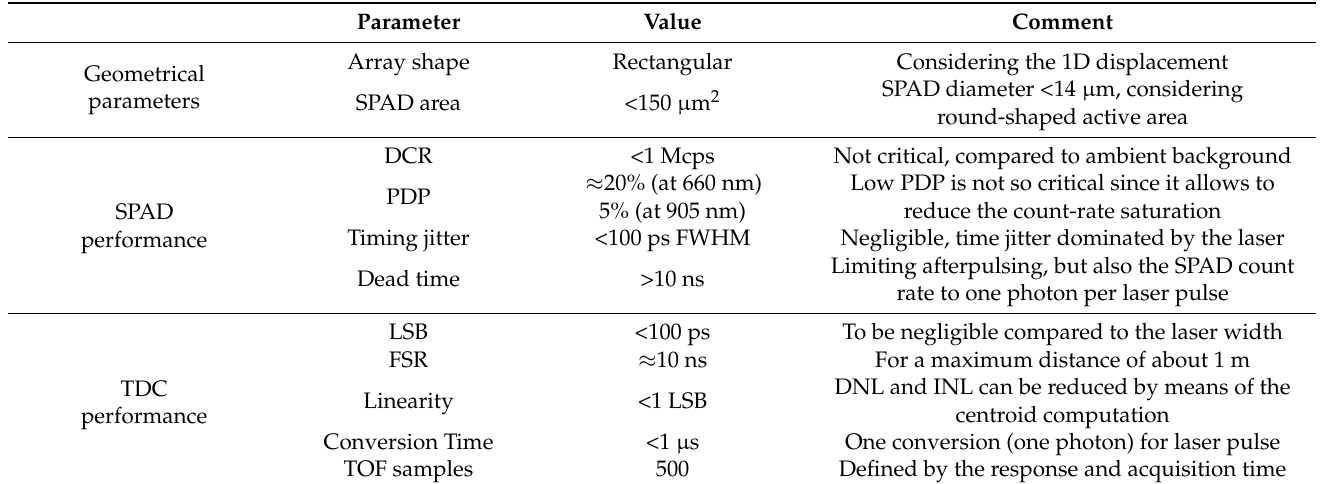
Table 4. Required performance and geometrical parameters of the SPAD